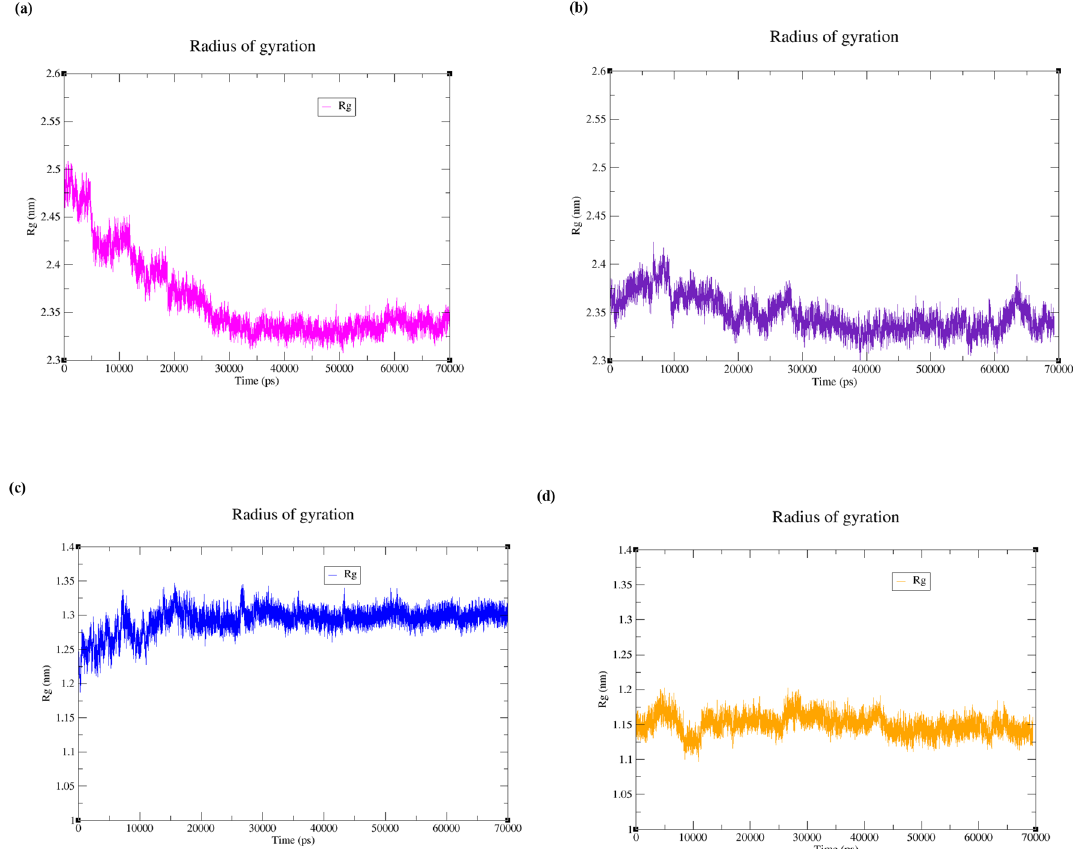
Figure 10. ( a ) Rg plot of protein in the presence of CNP. ( b ) Rg plot of protein in the presence of UNK4. ( c ) Rg plot of DNA strands in the presence of CNP. ( d ) Rg plot of of DNA strands in the presence of